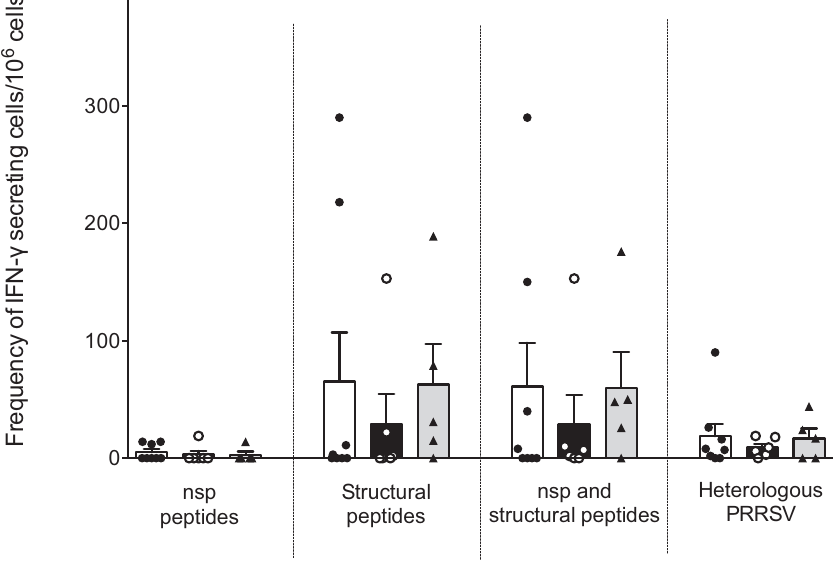
Figure 3. Cellular response against IFN-(cid:2) inducer peptides by multiparous and hyper-vaccinated sows. The IFN(cid:2)-SC frequencies between groups of sows against the pooled peptides from nsp and structural proteins of PRRSV were determined by ELISPOT IFN-(cid:2) assays of PBMCs. No statistical significance was observed in the IFN(cid:2)-SC frequency between sow groups. Each bar represents the mean ± standard deviation. White, black and gray bars represent the groups of sows with one, three and six parities,